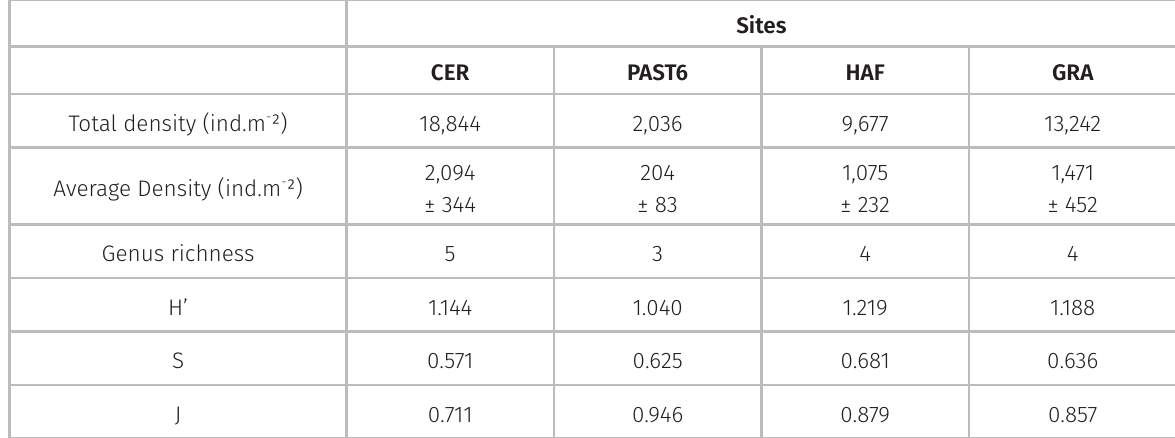
Table II. Abundance (total and average ± standard error of mean), genus richness and diversity indexes of enchytraeids in Cerradão (CER), Pasture (PAST6), Upper Montane Atlantic Forest (HAF) and Grassland (GRA) . Shannon-Wiener diversity index (H’); Simpson’s index (S) and Pielou evenness index (J). Sites CER PAST6 HAF GRA Total density (ind.m - ²) Average Density (ind.m -